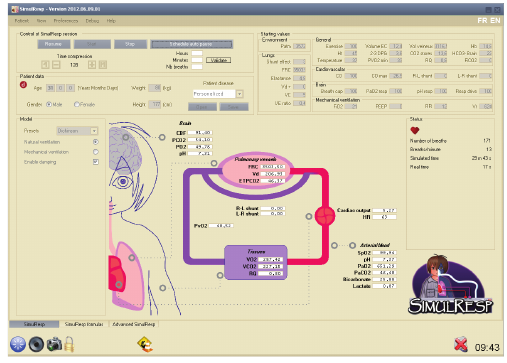
Figure 3: Picture of the cardiorespiratory simulator, SimulResp. Clinical Validation. Data from mechanically ventilated patients are compared to SimulResp prediction. A compari- son is made between expected and observed steady-state arte- rial blood gases in response to changes in ventilator